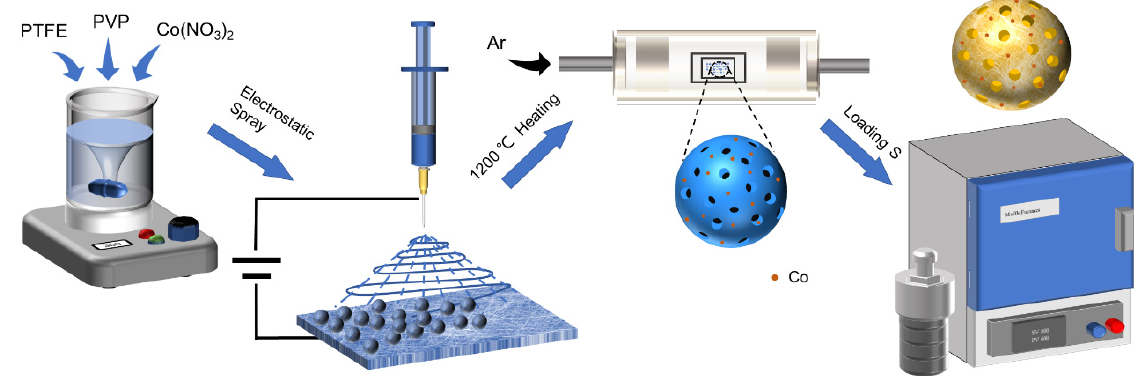
Figure 1. The synthesis scheme of Co/N-PCSs@S.